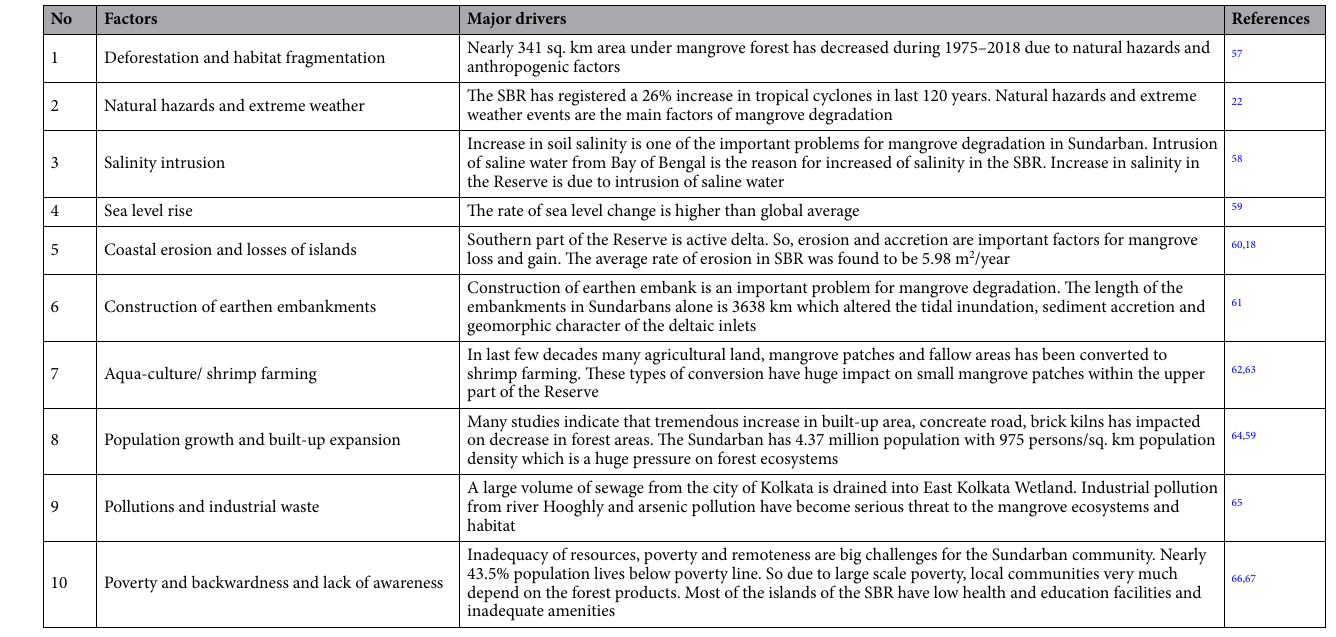
Table 1. Major drivers of mangrove degradation in Sundarban Biosphere